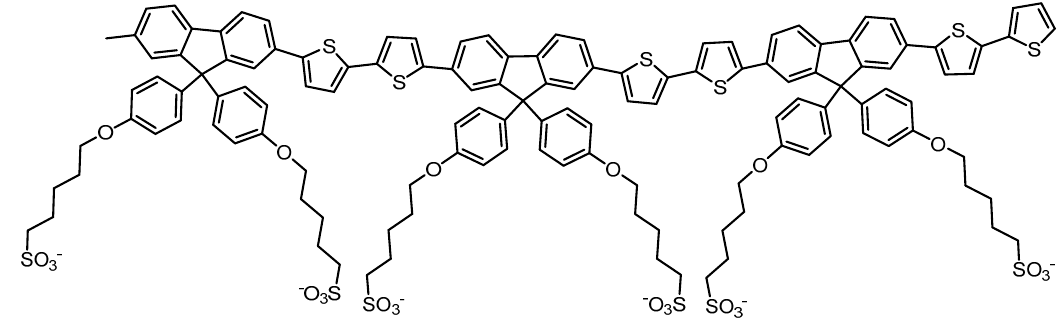
Figure 1. Chemical structure of PBS-PF2T polymer, representative of the trimer used in the MDS simulations.